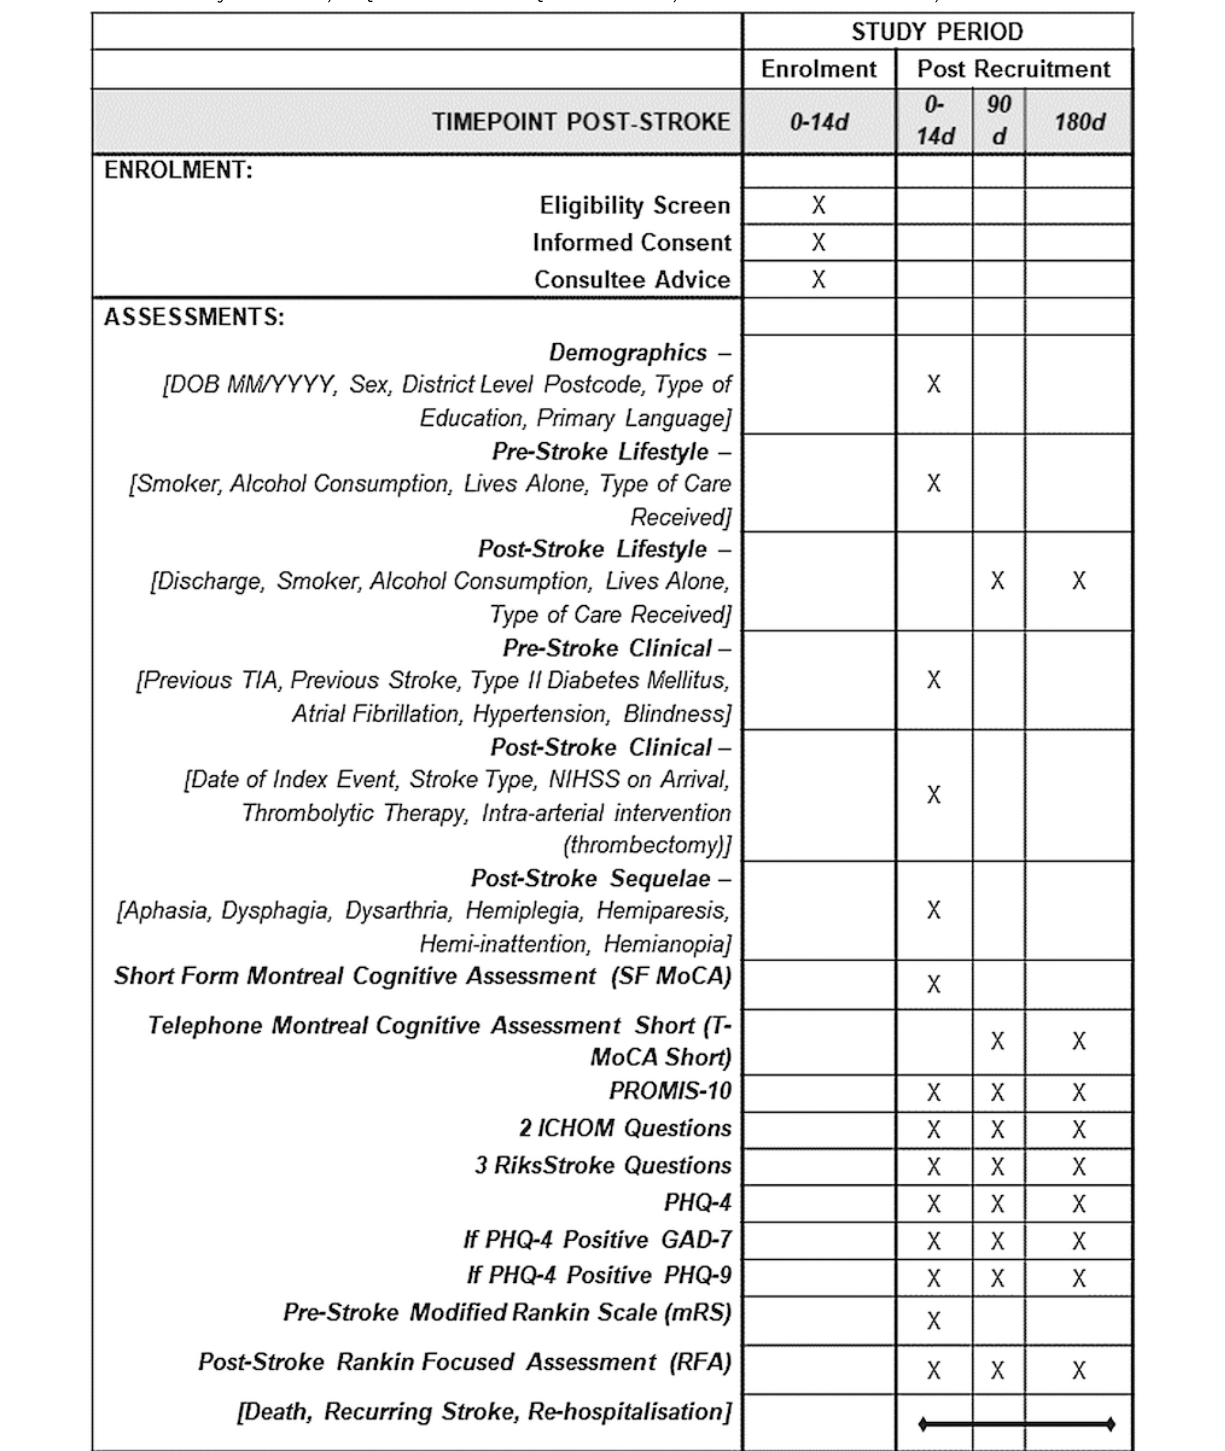
Figure 2. SPIRIT (Standard Protocol Items: Recommendations for Interventional Trials) checklist. SF MoCA: Short-Form Montreal Cognitive Assessment; T-MoCA-Short: Telephone Montreal Cognitive Assessment Short; PROMIS-10: Patient-Reported Outcomes Measurement Information System Global Health Short Form-10; ICHOM: International Consortium Health Outcomes Measurement; PHQ-4: Patient Health